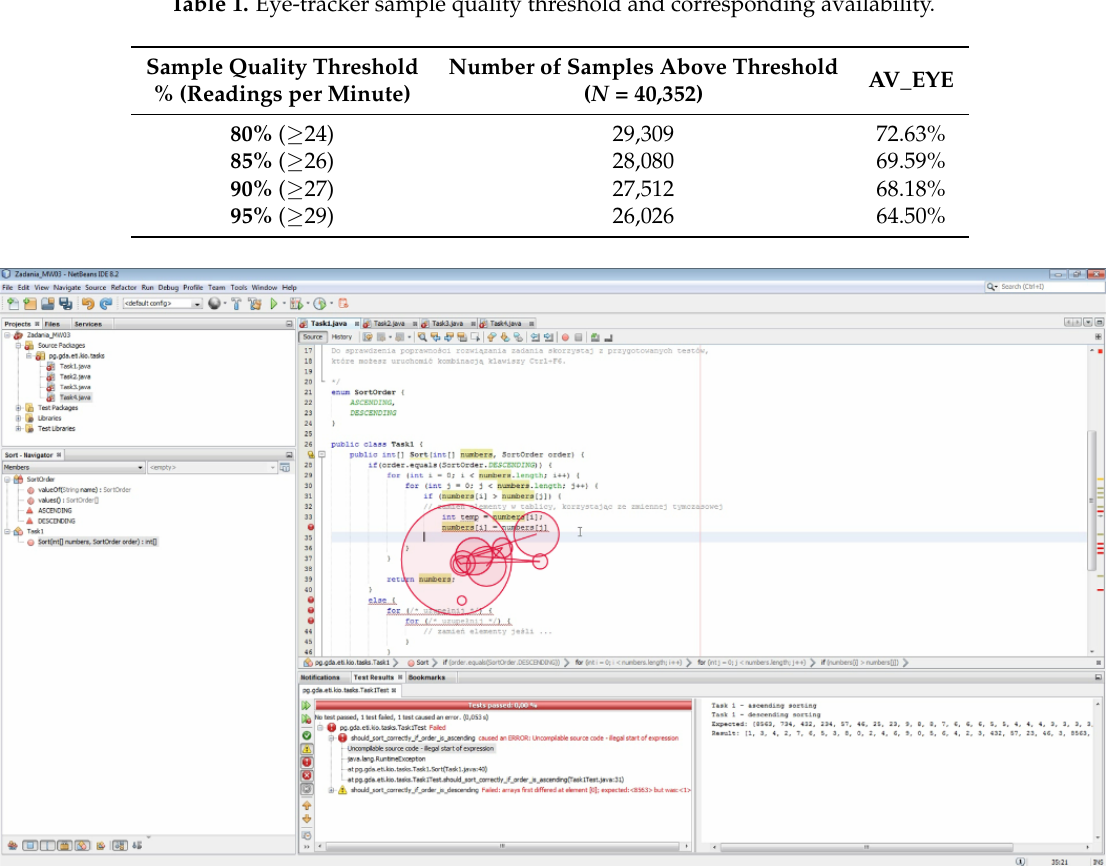
Figure 4. Fixations and saccades during Task